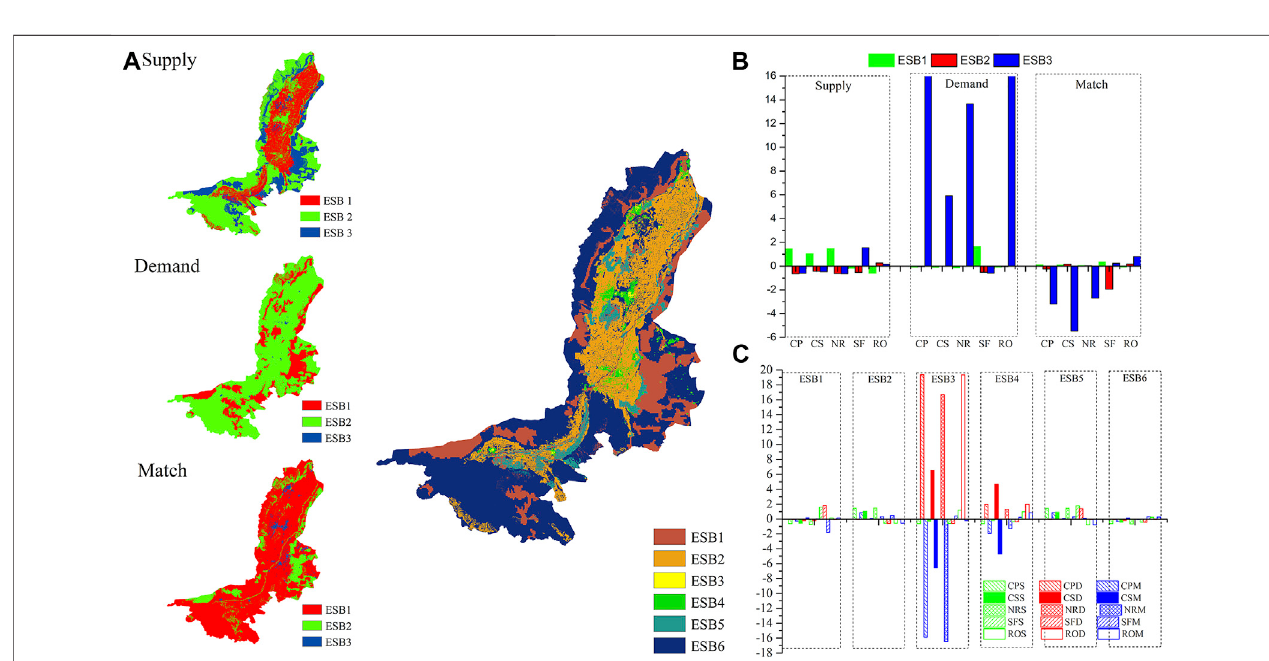
FIGURE 6 | Spatial distribution of ES bundles for supply, demand, match degree, and all three ES components (A) , and z-score values of ESs in each bundle (B) and (C) .